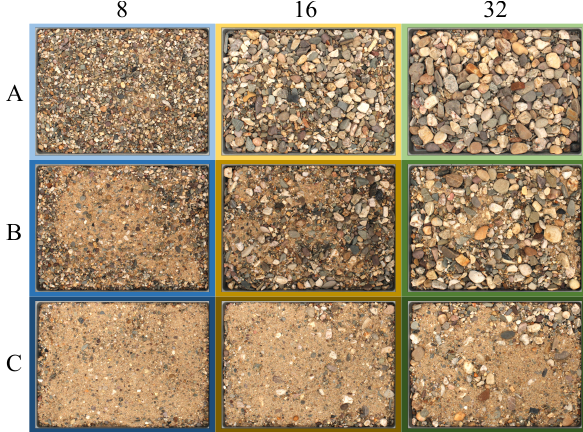
Figure 5. Example images of our data set for each of the nine distinguished grading curve classes. The colour-code of the background corresponds to the colour-code of the diagrams in Fig. 4 for an easier visual